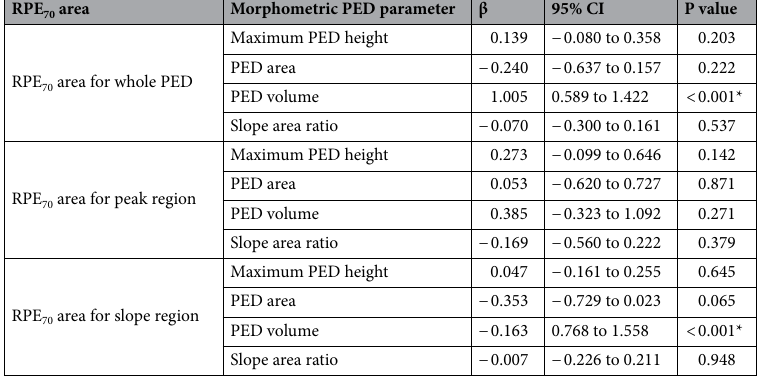
Table 3. Covariance parameter estimates of RPE 70 areas and morphometric retinal pigment epithelial detachment parameters. CI confidence interval, PED pigment epithelial detachment, RPE retinal pigment epithelium. *Statistically significant.